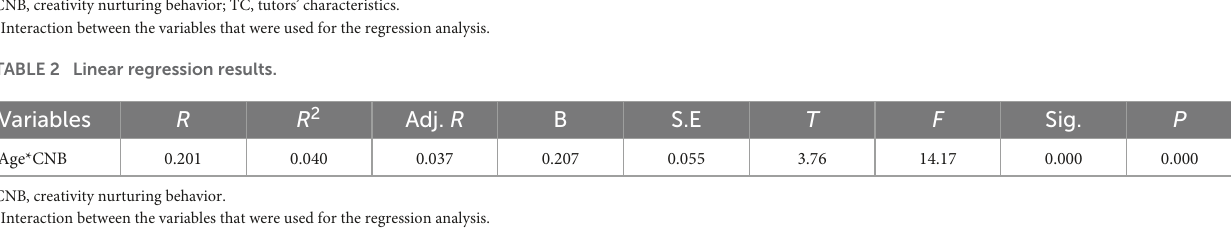
TABLE 3 Gender difference in tutors’ characteristics and their creative nurturing behaviors.